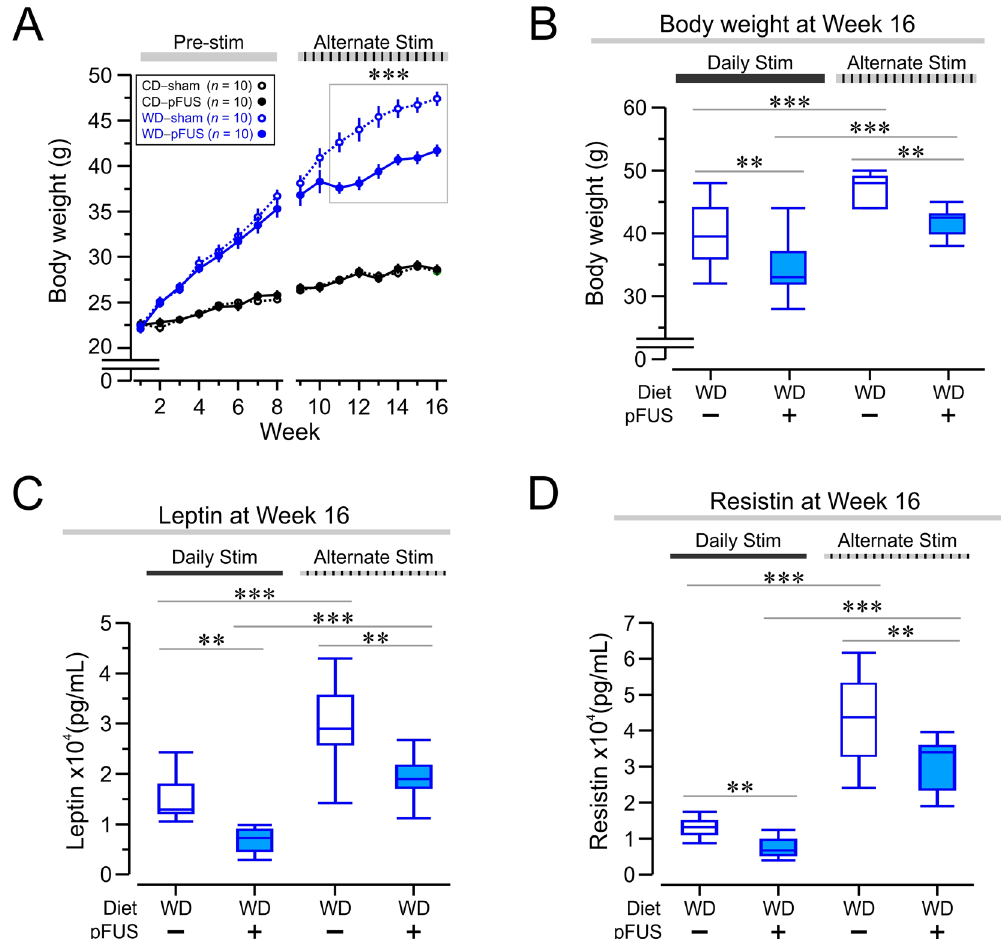
Figure 7. Dose-dependent effects of pFUS on weight gain and obesity-related metabolic derangements. ( A ) Alternate-day pFUS reduces the severity of body weight gain in Western diet-fed mice. By week 11, the Western diet–pFUS group (closed blue circles) had significantly lower body weights than the Western diet–sham group (open blue circles; *** P < 0.001, two-way RMANOVA). The sham groups did not differ significantly from each other throughout the study. ( B ) Alternate-day hepatic pFUS reduces body weight gain, but less robustly than daily stimulation. The endpoint weights of the daily stimulated Western diet-fed groups were compared to the alternate-day stimulated Western diet-fed groups. The daily stimulated Western diet–pFUS group was significantly lower than the alternate-day stimulated group (*** P < 0.001, two-way ANOVA, daily WD–pFUS vs alternate WD–pFUS). ( C ) Alternate-day stimulation attenuates leptin hormone elevation in Western diet–pFUS mice. At week 16, both daily and alternate-day stimulation regimens were sufficient to significantly lower leptin levels (** P < 0.01, two-way ANOVA). Comparison of daily and alternate-day stimulated Western diet–pFUS groups revealed that daily ultrasound stimulation significantly decreased leptin compared to alternate-day stimulation (*** P < 0.001, two-way ANOVA) ( D ) Hepatic pFUS significantly reduced resistin levels in both daily stim and alternate-day Western diet–pFUS groups compared to their respective Western diet–sham groups (** P < 0.01, two-way ANOVA). The daily stimulated Western diet–pFUS group had significantly lower resistin compared to alternate-day Western diet–pFUS (*** P < 0.001, two-way